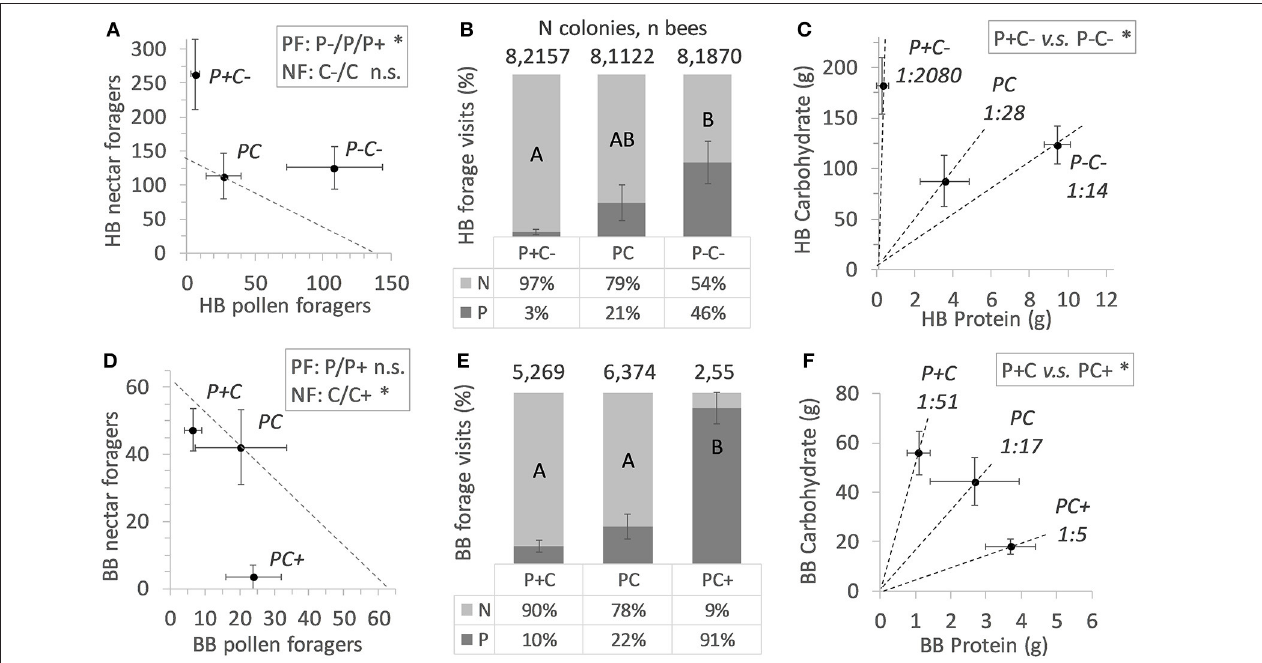
FIGURE 1 | Colony level effects of in-hive nutrient manipulations. Nectar forager (NF) counts and pollen forager (PF) counts are shown in (A) for honey bees (HB) and in (D) for bumble bees (BB), under conditions of increased or decreased protein (P) or carbohydrate (C) food stores. Mean active colony values of forager counts ± SE error bars are shown, with dotted diagonals indicating the mean forager number counted at baseline colonies. Statistical significance is indicated with an asterisk ( ∗ ). Foraging allocation to nectar (N) and pollen (P) is shown in (B,E) (mean % values ± SE error bars) with significant treatment effects indicated by different lettering ( post hoc Tukey HSD). Colony level P:C ratios are indicated in (C,F) with dotted lines illustrating the mean Protein to Carbohydrate intake ± SE error bars per treatment. Post hoc statistical significances are indicated with an asterisk ( ∗ ).